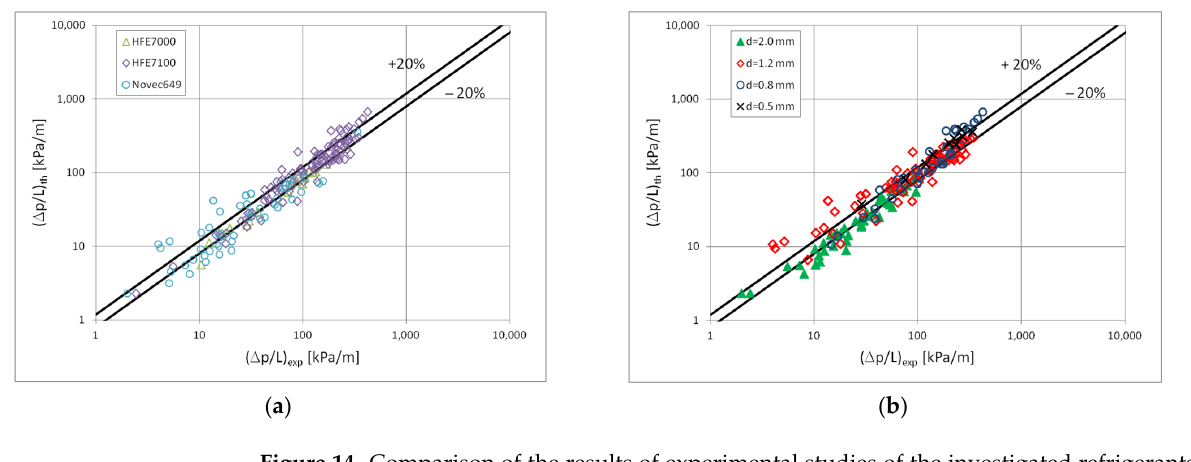
Figure 14. Comparison of the results of experimental studies of the investigated refrigerants con- densation in mini-channels in terms of pressure drops with the correlation (3) for the stratified flow; ( a ) for individual factors, ( b ) for individual mini-channels diameters.